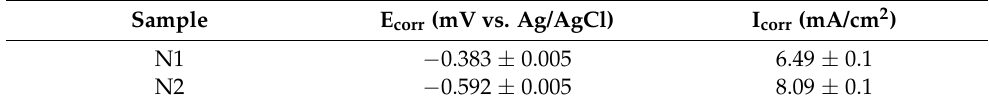
Figure 8. Comparison of potentio-dynamic curves for the investigated steels in NaCl 3.5% solution open to air at room temperature. Table 3. Selected interaction activity coefficient in dilute solutions of the steels.